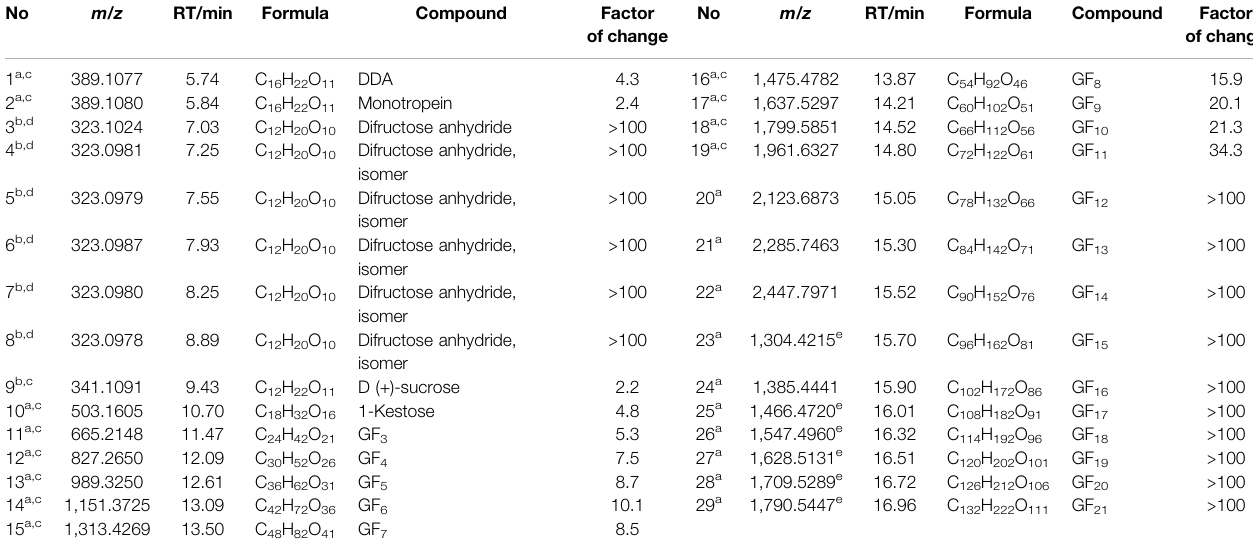
TABLE 1 | Chemical components with larger difference in content between the samples of MOR and PMOR (Acquity BEH amide